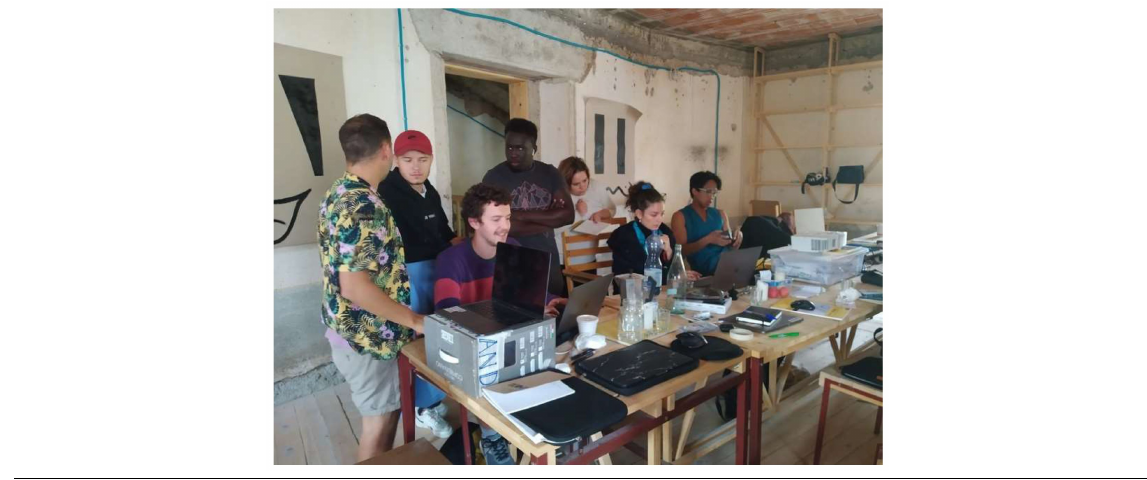
Figure 4. The studio space and living room in the Casa in 2020 (Source: photograph by Francesca